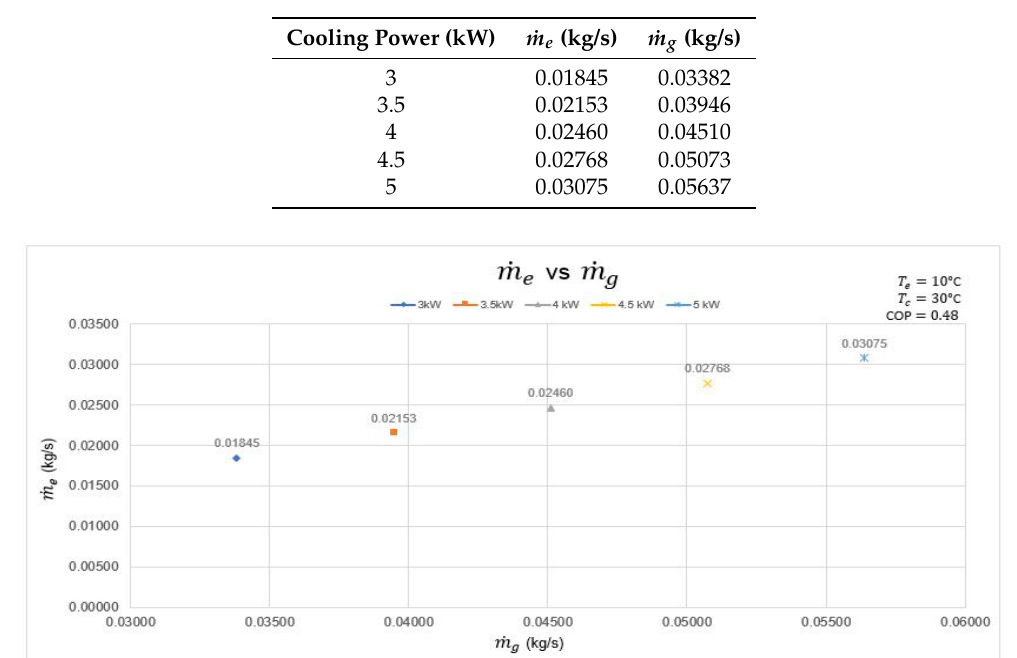
Figure 10. Mass flow of the generator ( ˙ m g ) and evaporator ( ˙ m e ) considering five different powers